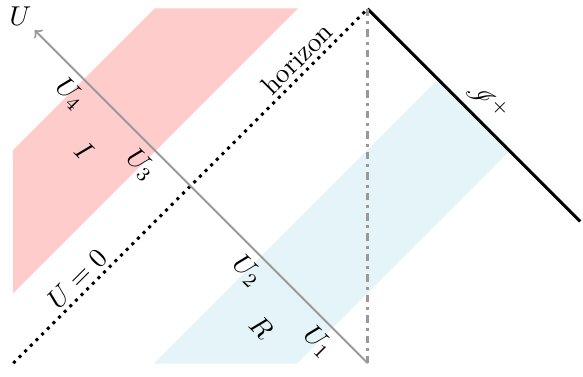
Figure 3 . A subset of outgoing modes in the interval R = [ U 1 , U 2 ] at I + and an interval I = [ U 3 , U 4 ] behind the horizon (so with an order 1 , 2 , 3 , 4 along a Cauchy slice that asymptotes to I + from right to